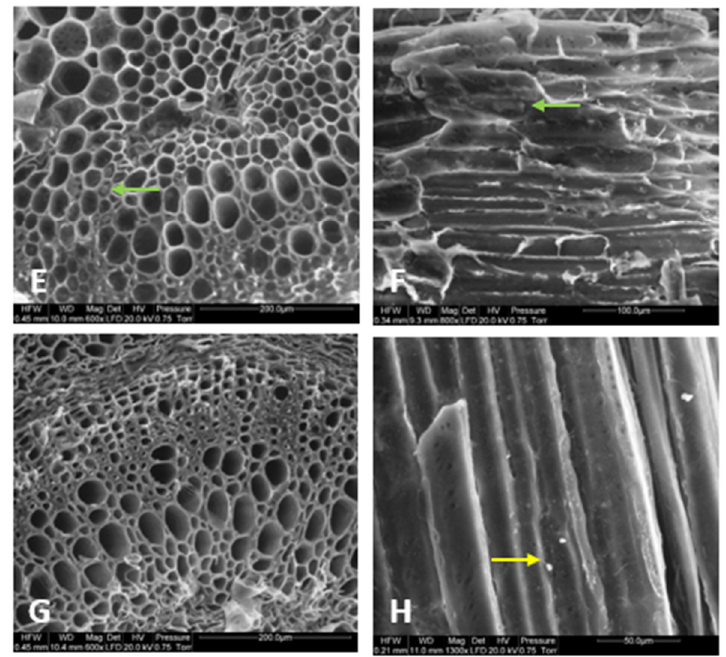
Figure 3. Cross-section ( A , C , E , G ) and longitudinal section ( B , D , F , H ) through the stem of peony